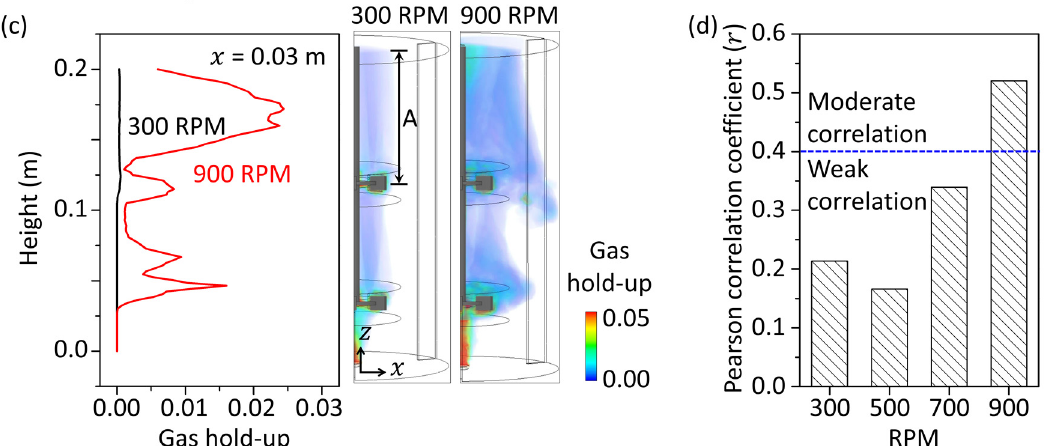
Figure 5. ( a ) Axial distribution of the turbulent dissipation rate, ( b ) number density of each size of bubble, and ( c ) axial distribution and contour of the gas hold-up at 300 and 900 RPM. ( d ) Pearson correlation coefficient between the volumetric mass transfer coefficient and dissolved carbon monoxide concentration with different RPMs.